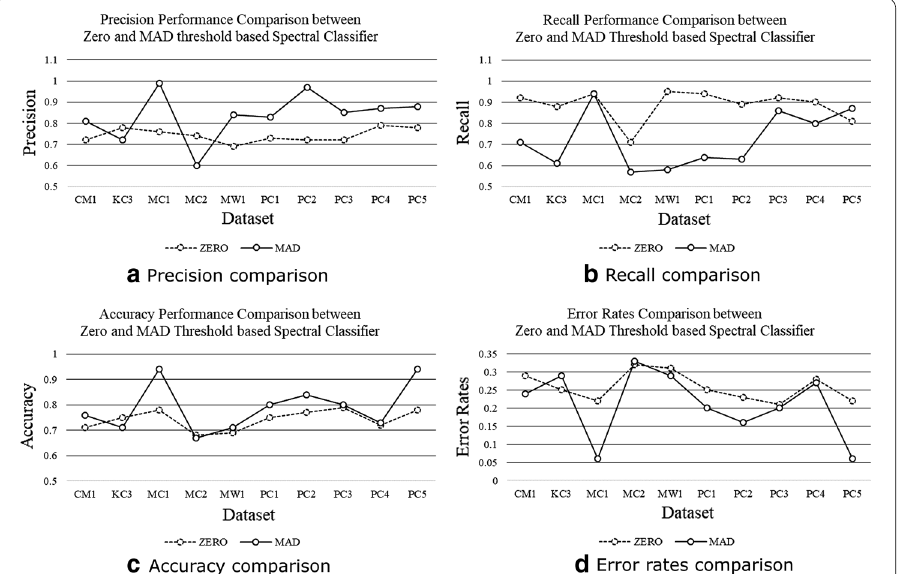
Fig. 3 Performance comparison. a – d illustrate the performance comparison between the zero threshold based spectral classifier and MAD threshold based spectral classifier in precision, recall, accuracy, and error